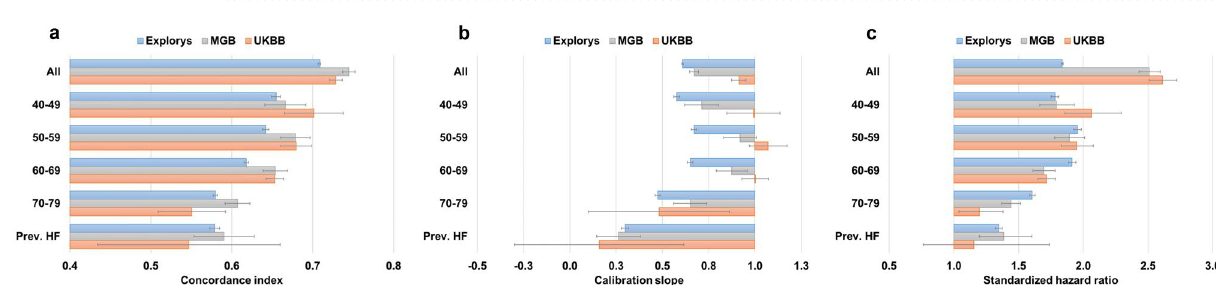
Figure 4. Performance measures for PCE (Female-White). Prev. = Prevalence; HF = Heart failure. Refer to Supplementary Table VIII for additional PCE